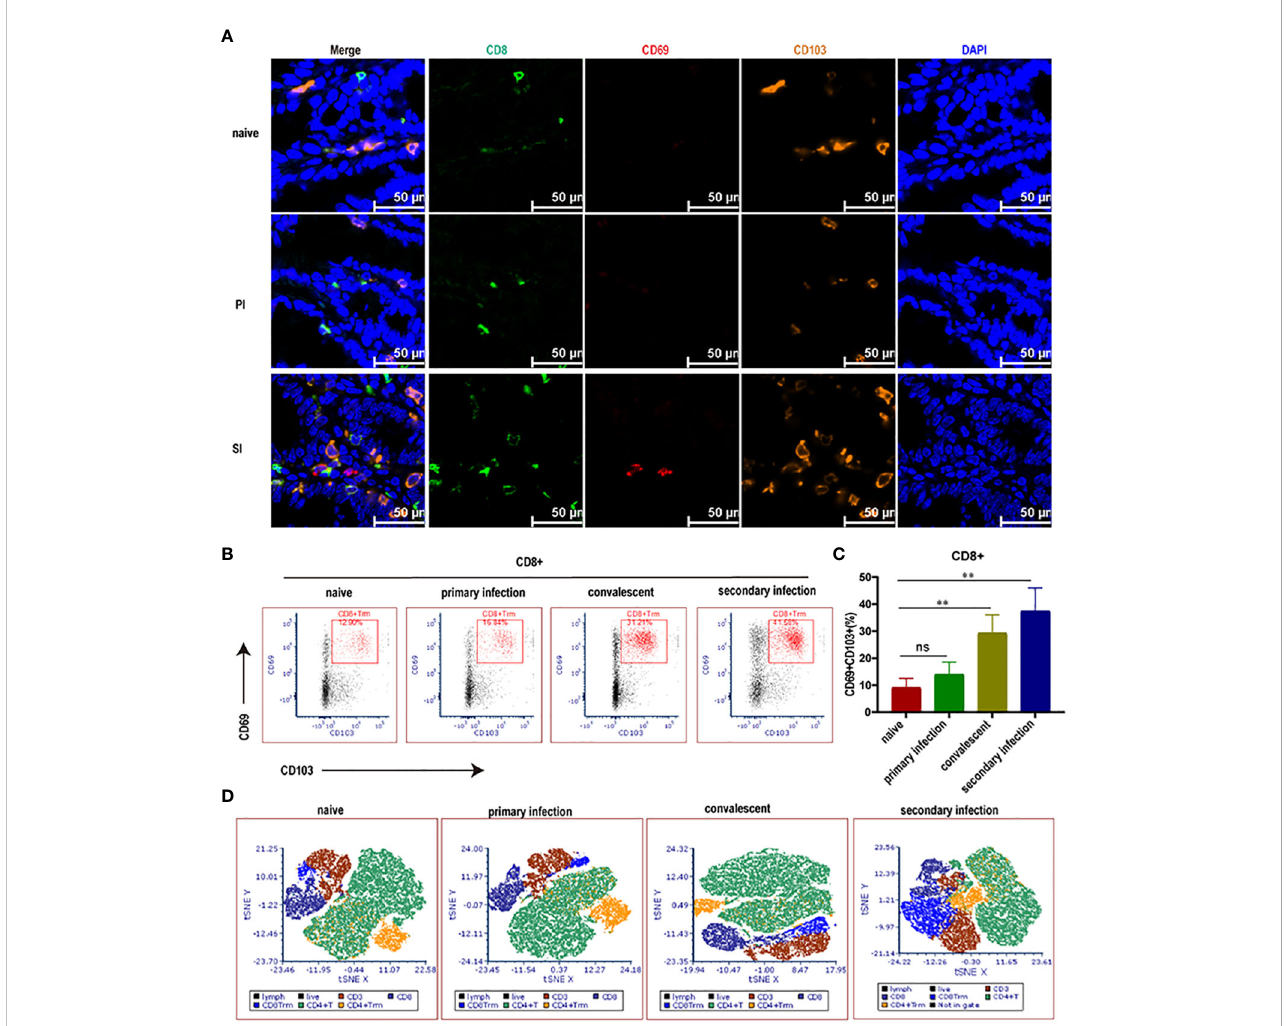
FIGURE 3 Cecal CD8 + Trm cells (in blue color) rose rapidly in reinfected mice. (A) Multi-parameter immunohistochemical staining for CD8 + , CD69 + and CD103 + Trm cells enriched in the cecum at 24 hours post primary infection and reinfection with 5000 E. falciformis . n =3 per treatment group, scale bar =50 m m. (B) Representative fl ow cytometric plots for expression of CD69 + and CD103 + on CD8 + T cells in LP of cecum at 24 hours post primary infection and reinfection with 5000 E. falciformis . n =6 per treatment group. (C) Summary bar graph of CD8 + Trm, gated on live CD8 + cells. (D) t-Distributed Stochastic Neighbor Embedding (tSNE) plots of LP-in fi ltrating single CD3 + cells. Results are mean ± SD from three independent experiments, ns, no statistical signi fi cance, ** p ≤